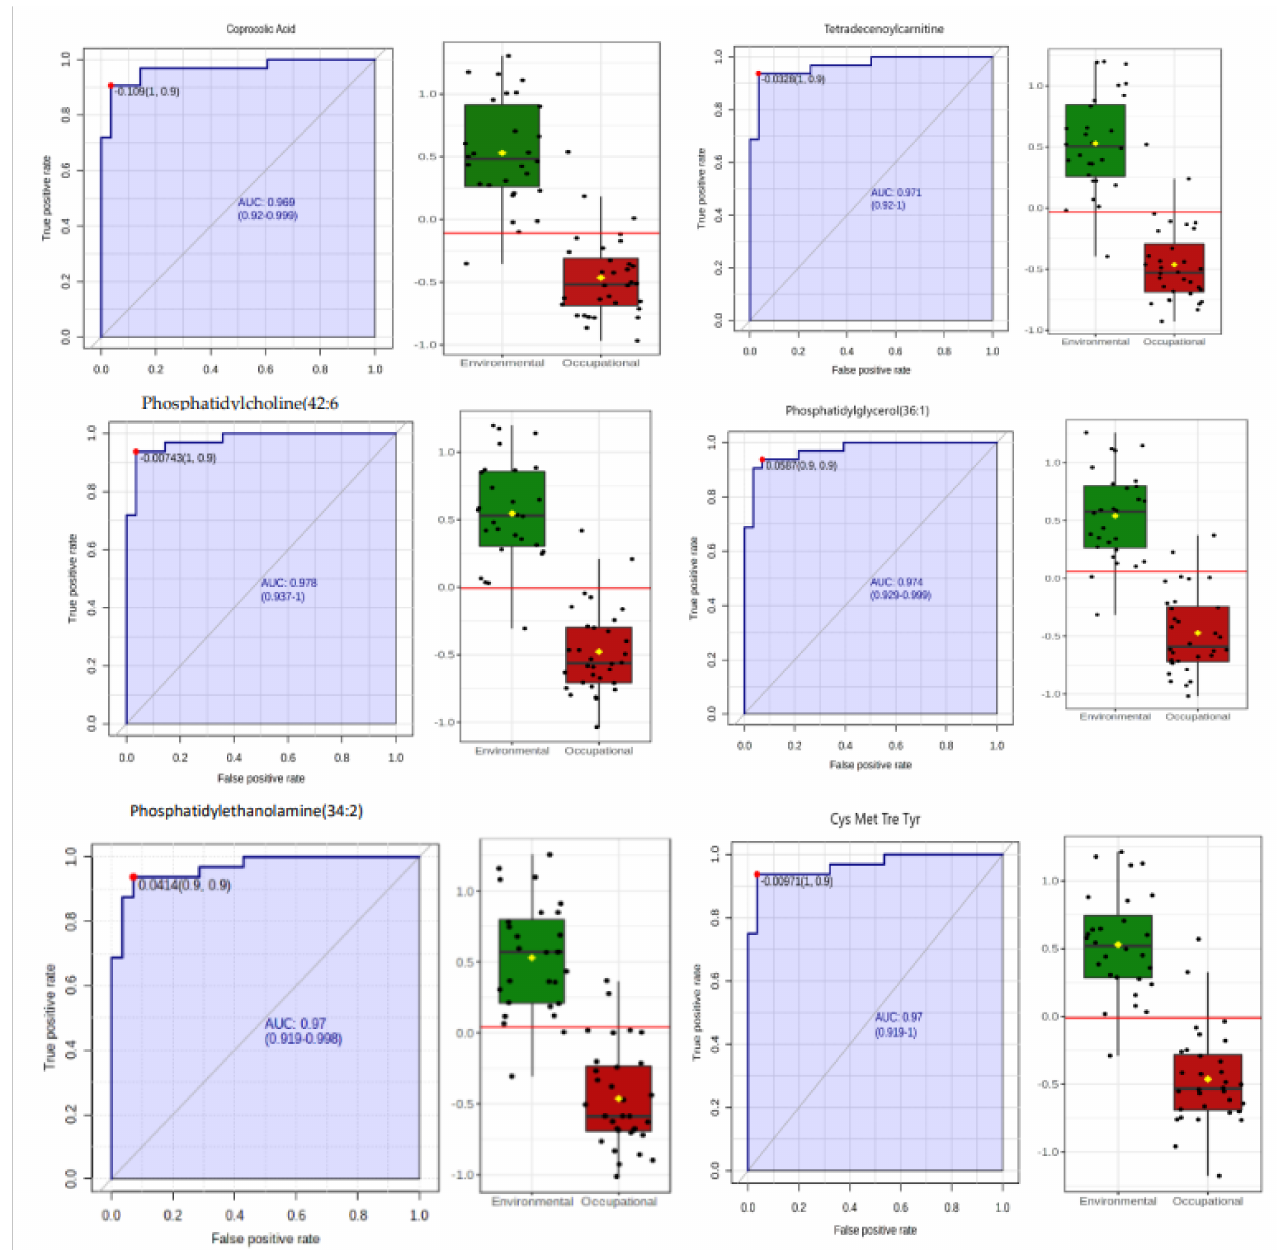
Figure 6. ROC curves of the discriminating urinary metabolites associated with oxidative stress and chromosomal aberrations induced by exposure to low concentrations of benzene. Note: On the left, the graphical representation of the calculated ROC curve with a 95% confidence interval for each biomarker candidate. AUC = area under the ROC curve. On the right, boxplot of metabolite concen- trations in the environmental (green) and occupationally (red) exposed groups. A red horizontal line indicates the optimal cutoff